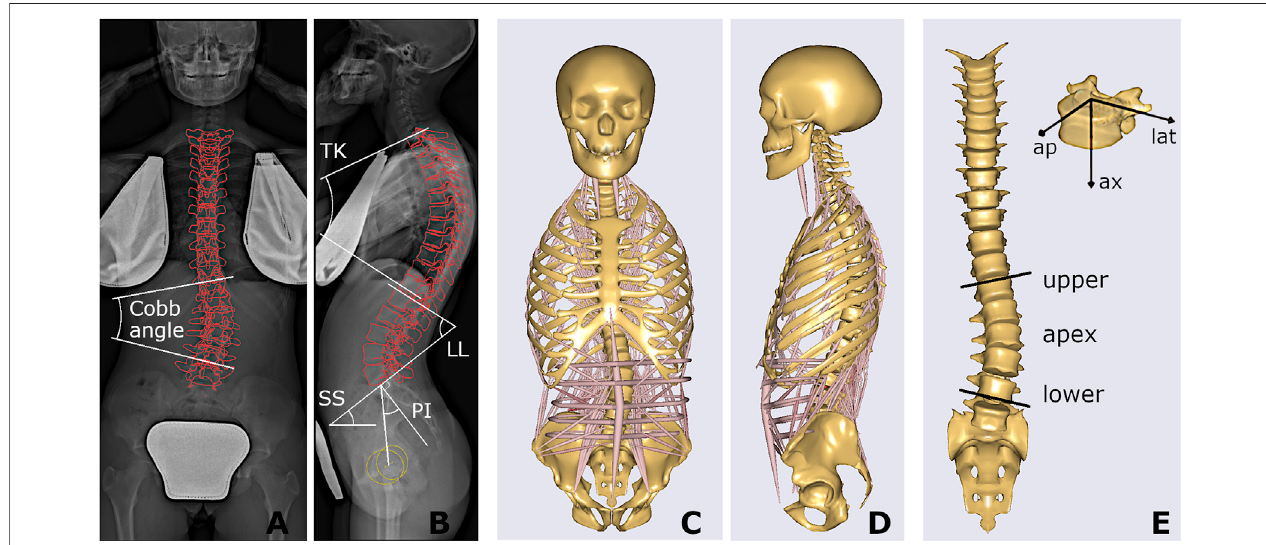
FIGURE 2 | Coronal and sagittal radiographic images of one stable subject, with projection of the reconstructed vertebrae and illustration of Cobb angle, spinal sagittal alignment (TK, LL) and spinopelvic angles (SS, PI) (A,B) ; and corresponding musculoskeletal model (C,D) , also presented highlighting the scoliotic curve (apex, upper and lower end levels) with muscles and ribcage not shown, and the local vertebral reference system, i.e., anteroposterior (ap), lateral (lat), and axial (ax) component (E) .